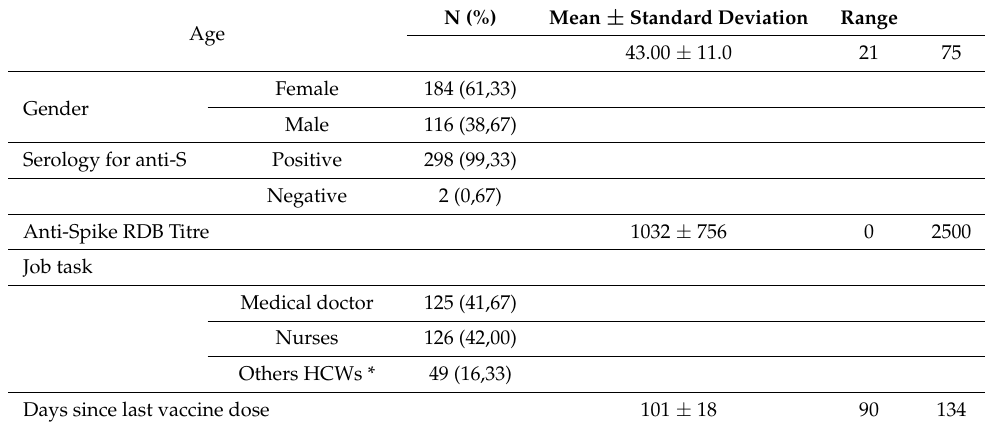
Table 1. Study population characteristics by vaccination and serological status.